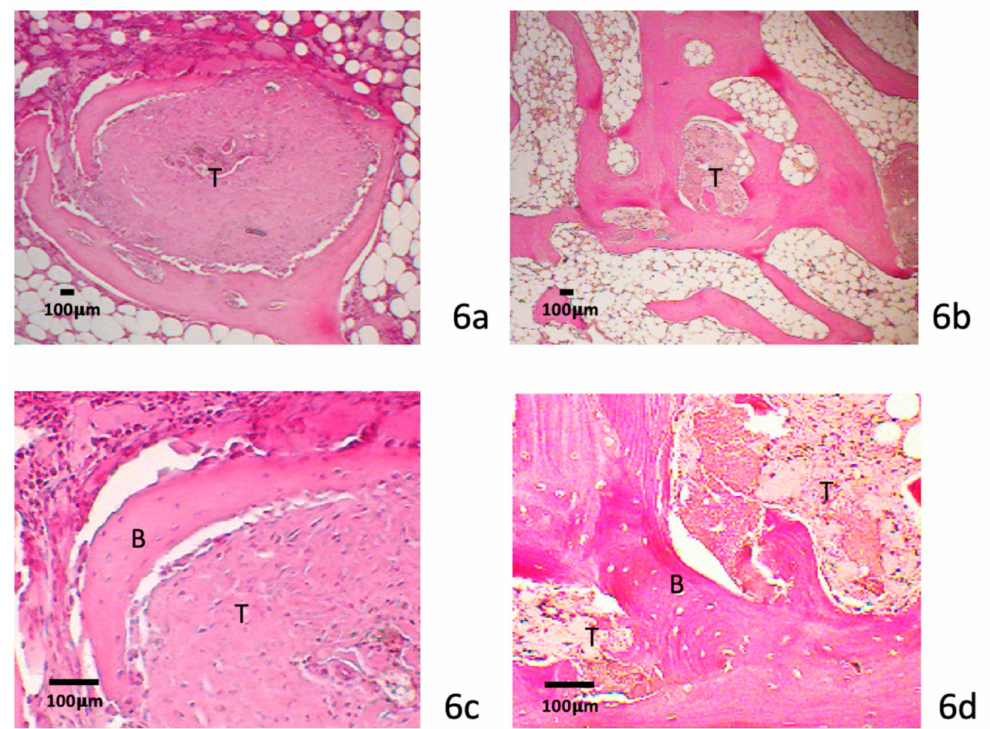
Figure 6. Eight-week specimens histology. Wider dense interface tissue between the tendon (T) and bone (B) in the 8-week study group ( a , b ). New bone formation with incorporation into the tendon graft is illustrated ( c , d ). The tendon graft was replaced by new bone formation after collagenase treatment. (scale bar: 100 µ